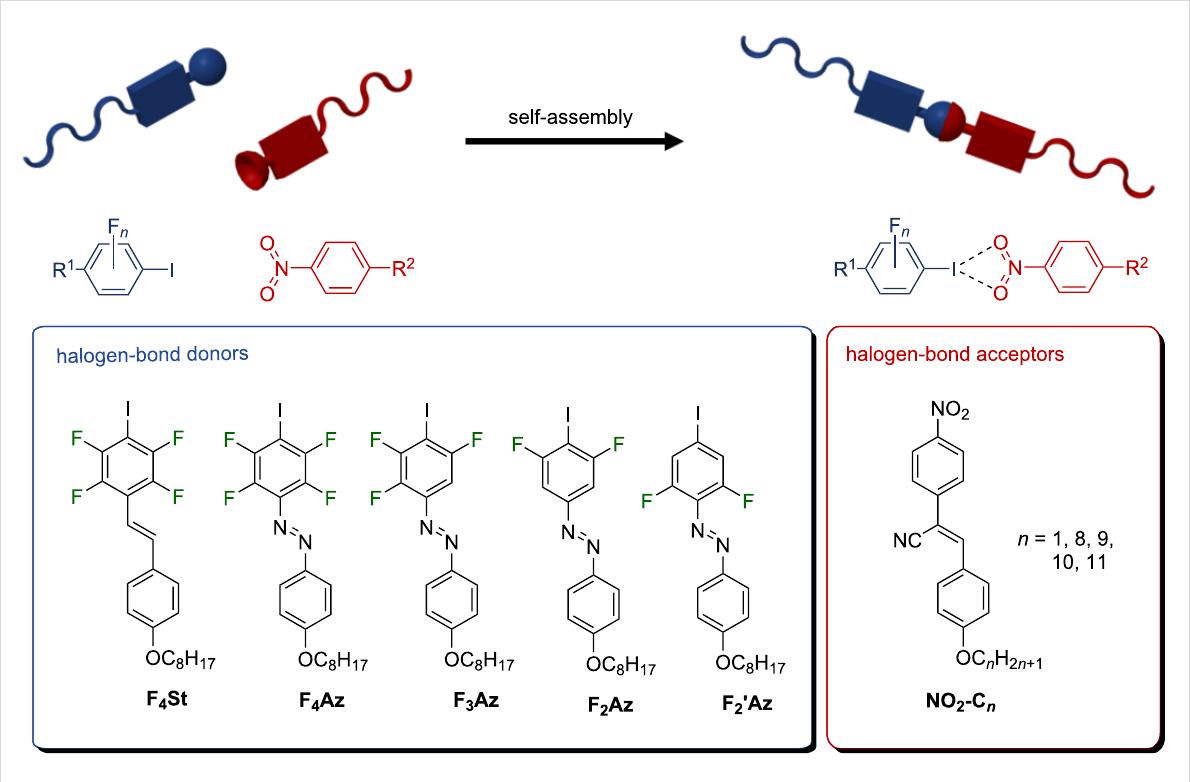
Figure 1: Schematic representation of the modular approach towards halogen-bonded fluorescent liquid